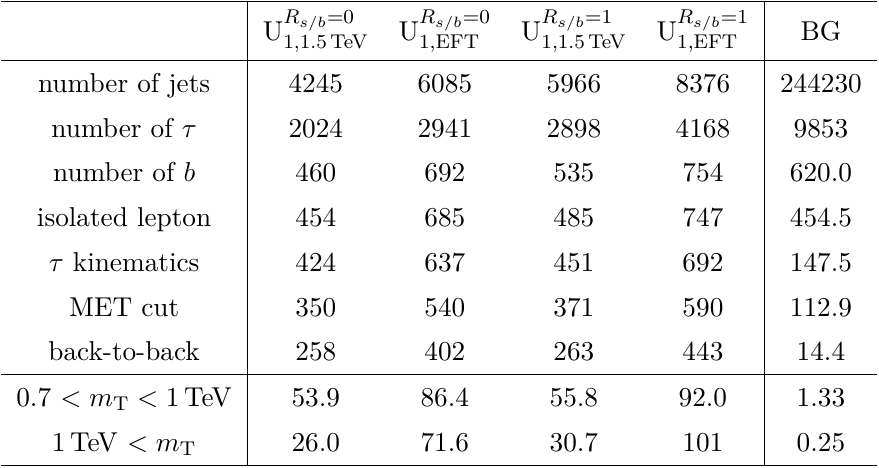
Table 14 . Same as table 13 but for the U 1 LQ scenario with the U(2) flavor symmetry, where R L dt C V = 1 and = 35 . 9 fb − 1 1